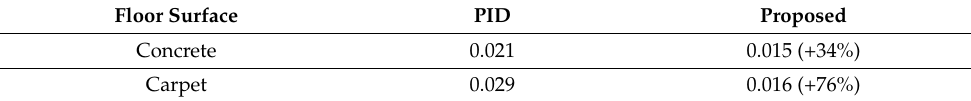
Table 1. RMS Path tracking error (m)